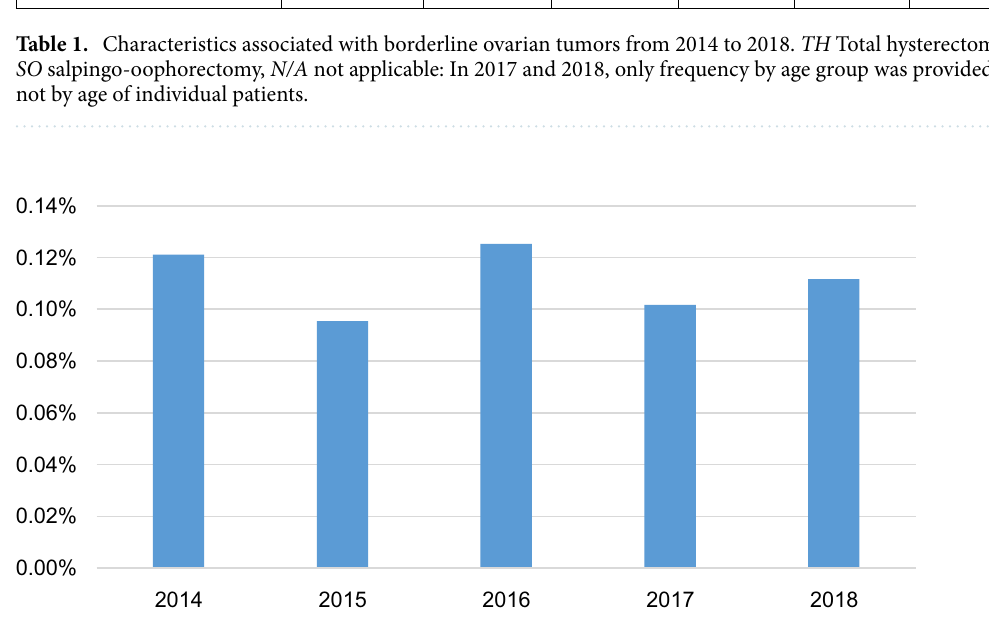
Figure 1. The annual trends in the prevalence of borderline ovarian tumors from 2014 to